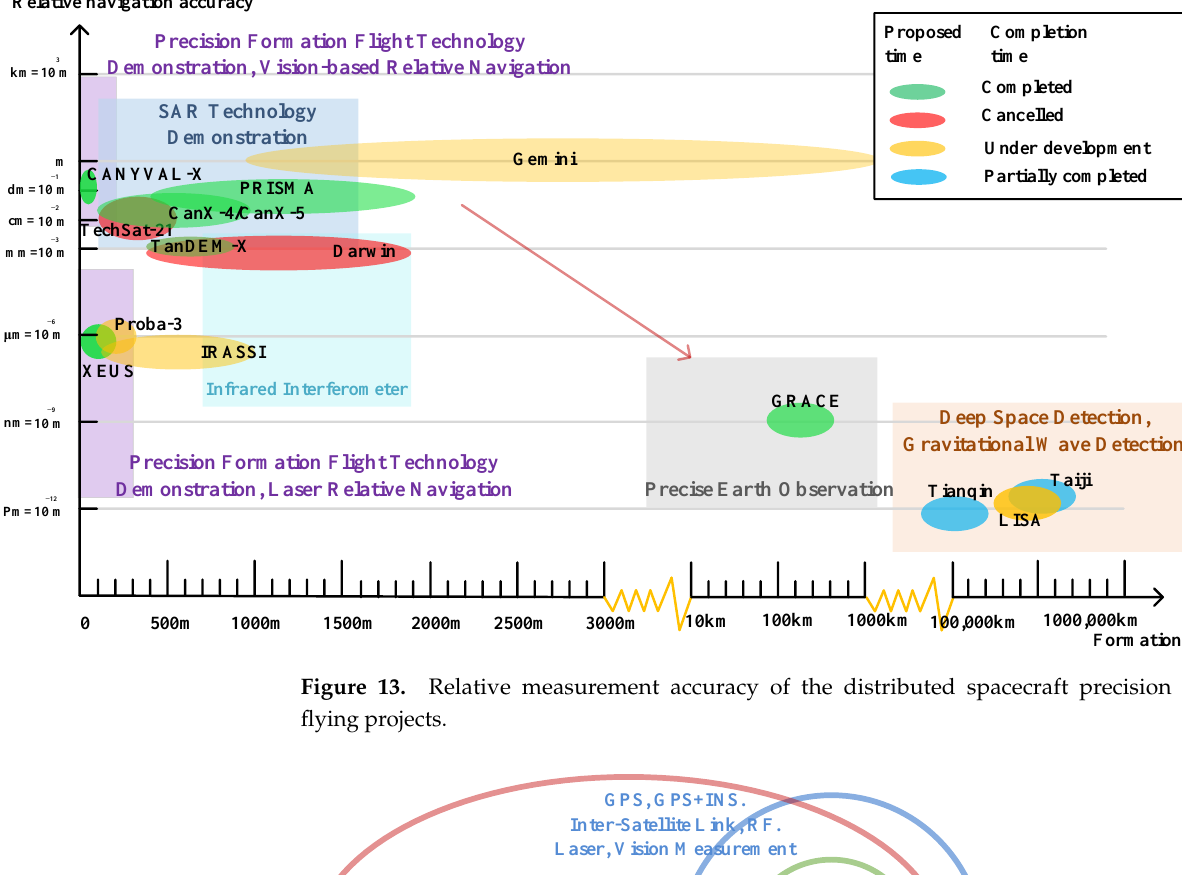
Figure 15. Principle diagram of the GPS relative measurement system. GPS relative measurement technology is used to ascertain relative information by obtaining absolute information. Its advantages are its mature technology, it is lightweight, and has low power consumption. Its disadvantages are that its reliability and safety cannot be guaranteed in a highly dynamic space environment. It is only suitable for low – medium-orbit formation tasks and cannot effectively cover high-orbit areas. The GPS measurement algorithm is divided into the carrier phase difference (CDGPS), relative pseudo-range difference, and relative position difference. The accuracy and scope of action are shown in Table 7. Table 7. Performance comparison of GPS measurement methods. Method